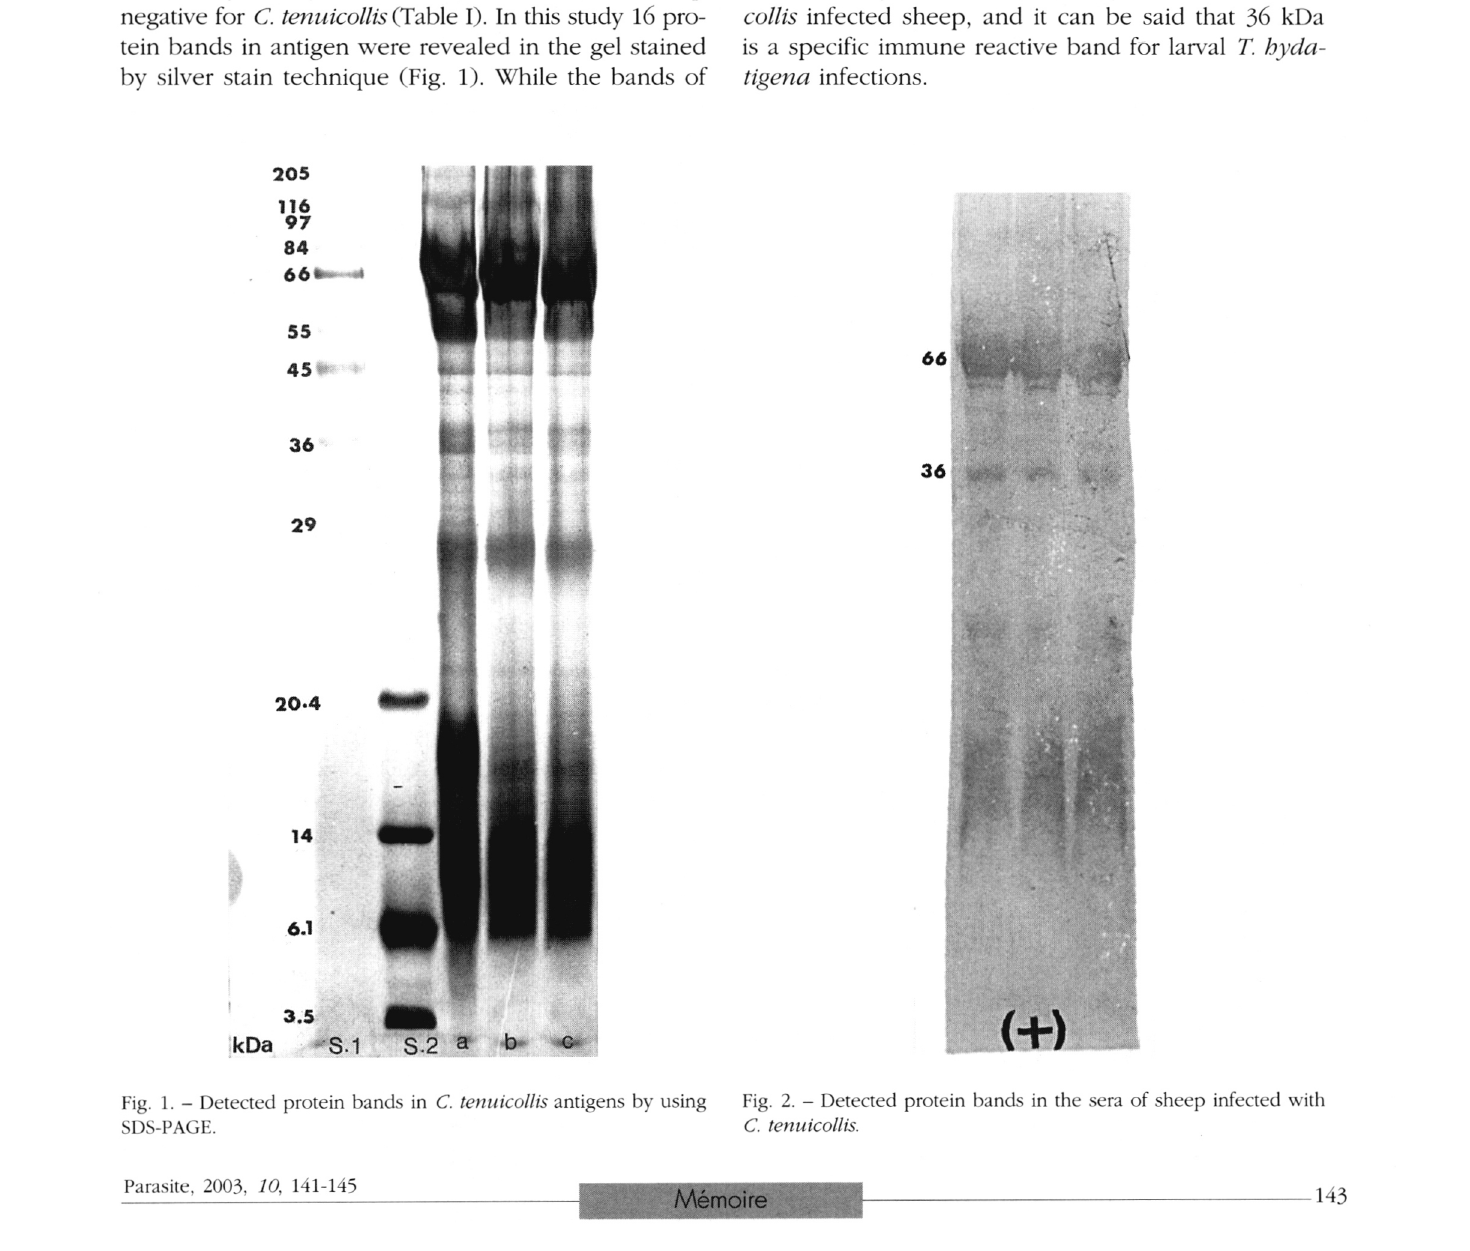
Fig. 1. - Detected protein bands in C. tenuicollis antigens by using SDS-PAGE.